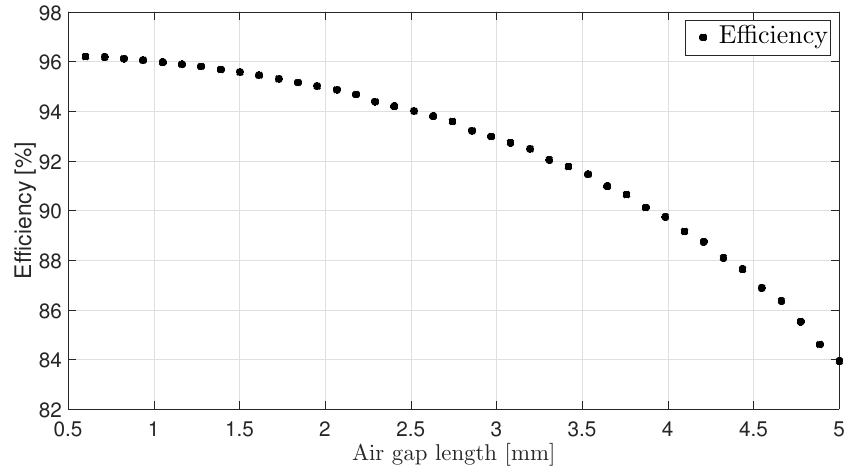
Figure 8. The efficiency variation with the air gap length.